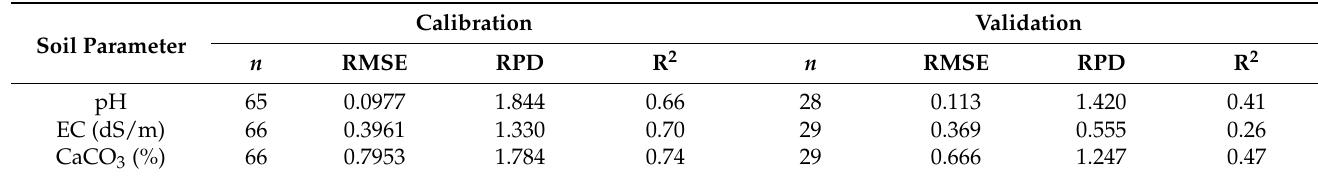
Table 7. The obtained data of SVR models for each soil parameter.